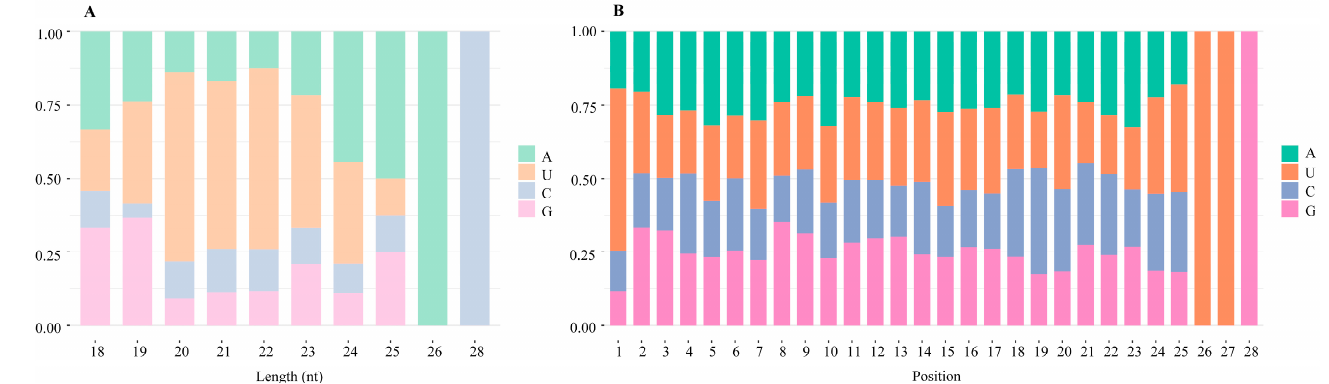
Figure 2. Base distribution of the C. album miRNAs identified in this study. ( A ) First nucleotide bias of C . album miRNAs. ( B ) miRNA nucleotide bias at each position. The A, U, C, and G bases are presented in green, orange, blue, and pink, respectively.